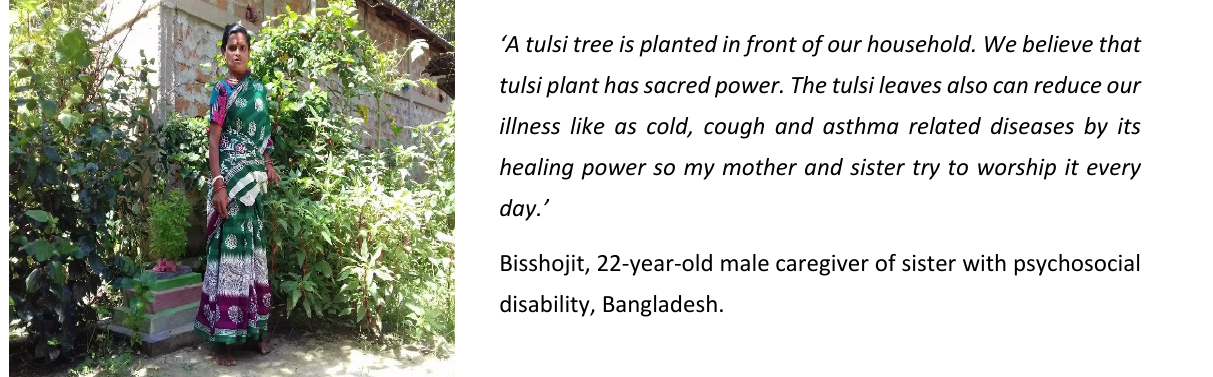
Figure 17. Alt-text: A woman dressed in a colourful green, white and purple sari standing in front of bushes and tulsi plants.